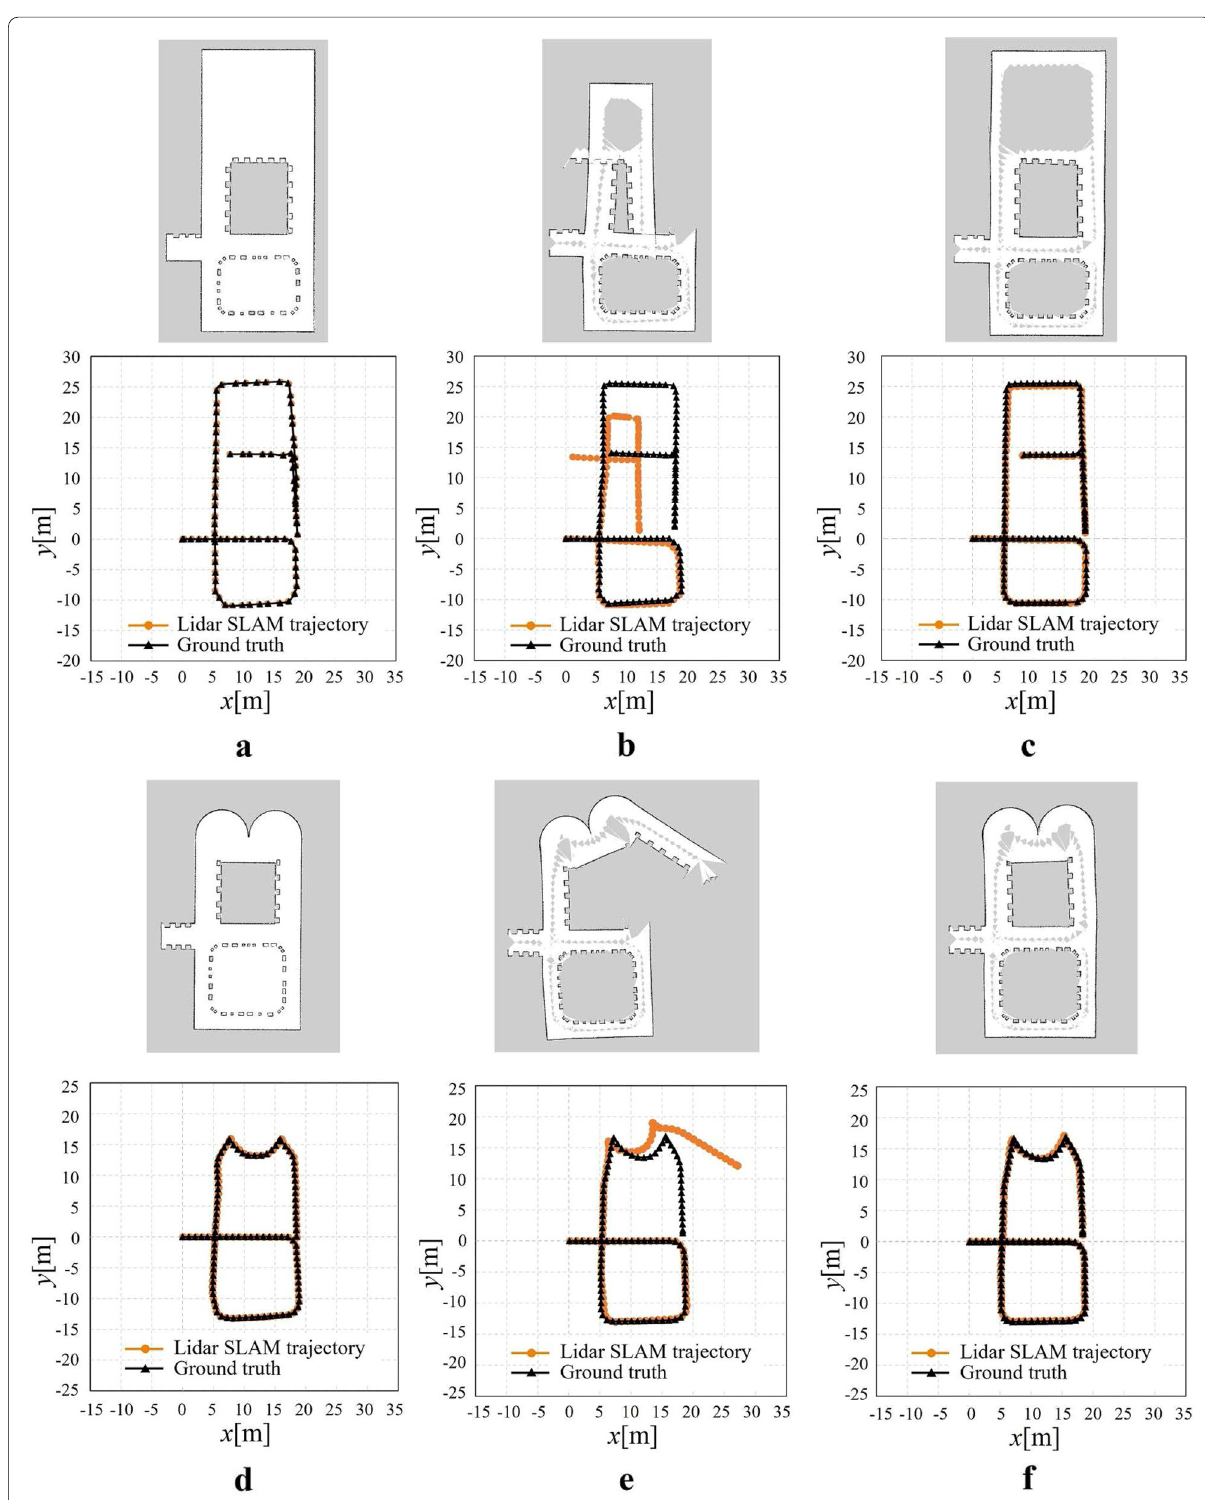
Fig. 8 Environmental map and robot trajectory from Lidar SLAM. a, b, and c are the environment for dealing with degeneracy in the direction of translation; d, e, and f are the environment for dealing with degeneracy in the direction of rotation. a and d Measurement distance 30m, b and e Measurement distance 4m, c and f Measurement distance 4m (proposed